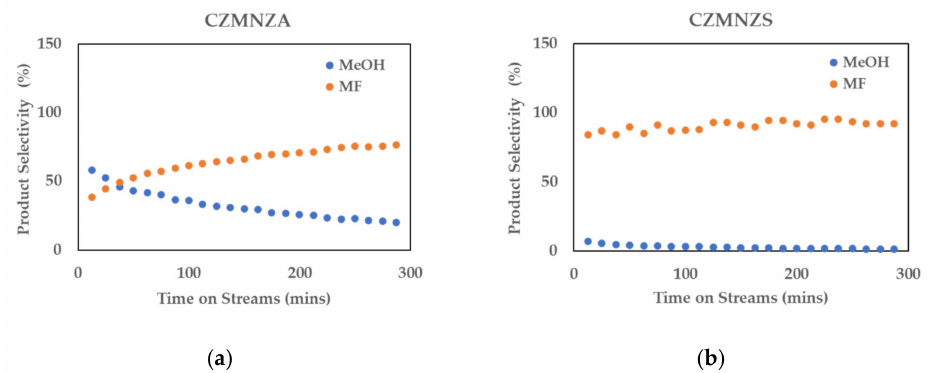
Figure 17. TOS of CO 2 conversion at reduction temperature 400 ◦ C.